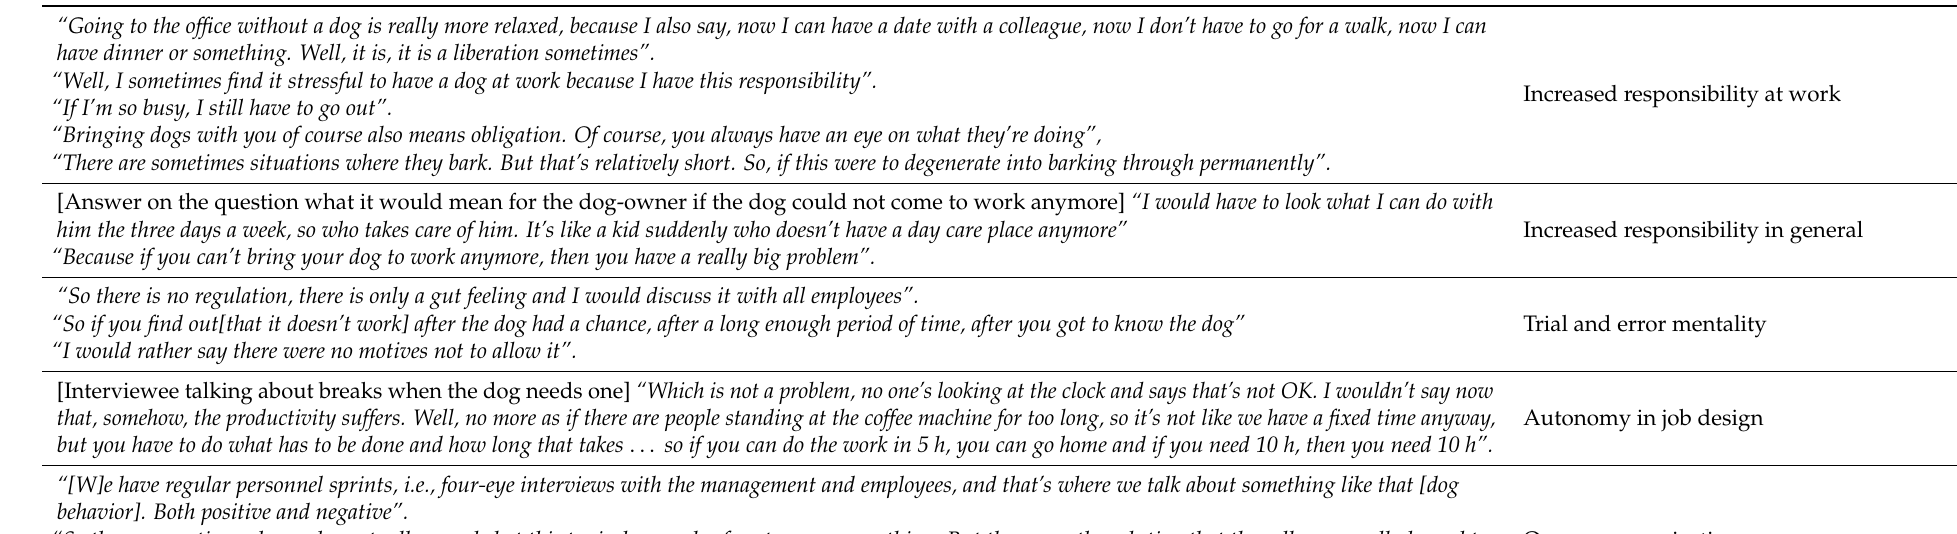
Table 2. Quotes leading to first-order